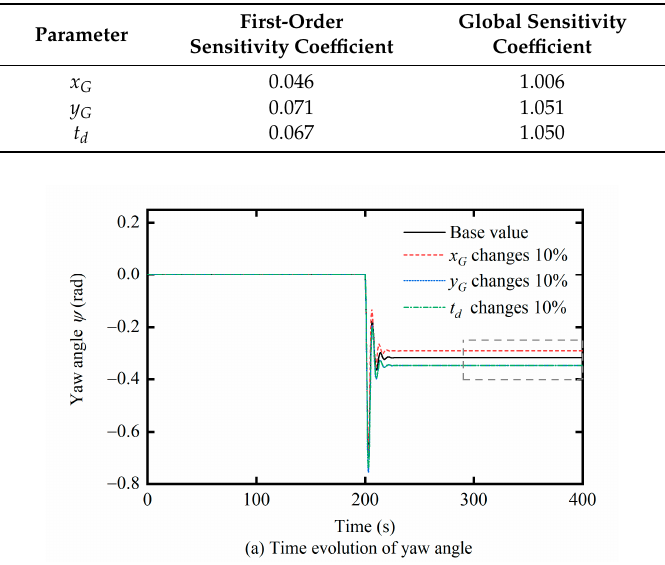
Table 5. First-order sensitivity coefficient and global sensitivity coefficient of each parameter.